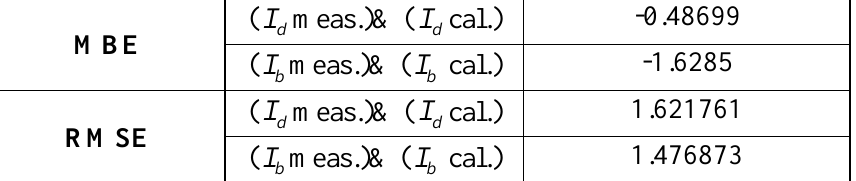
Table 6: The mean bias error (MBE), the root mean square bias error (RMSE) were applied to test the quality of the calculated values of diffuse and direct solar